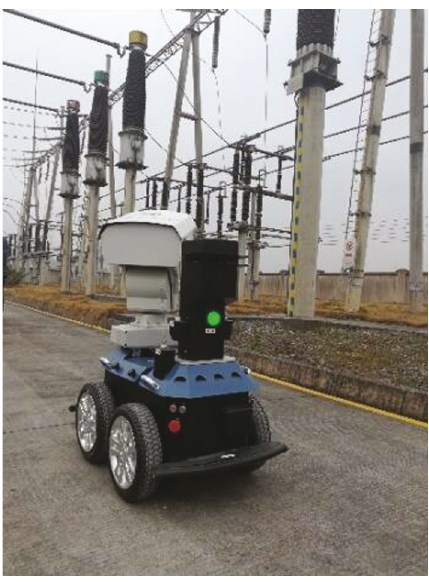
Figure 1: Power substation experiment